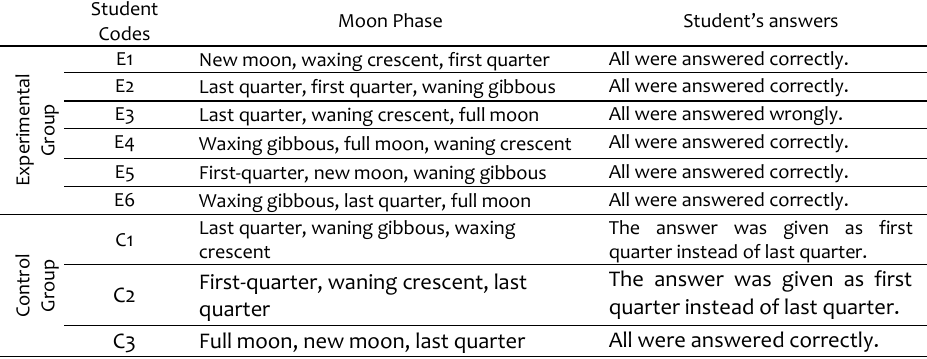
Table 9. Answers regarding the interviewed students’ predicti ons about the Moon phases from the positions of the Sun, Earth and